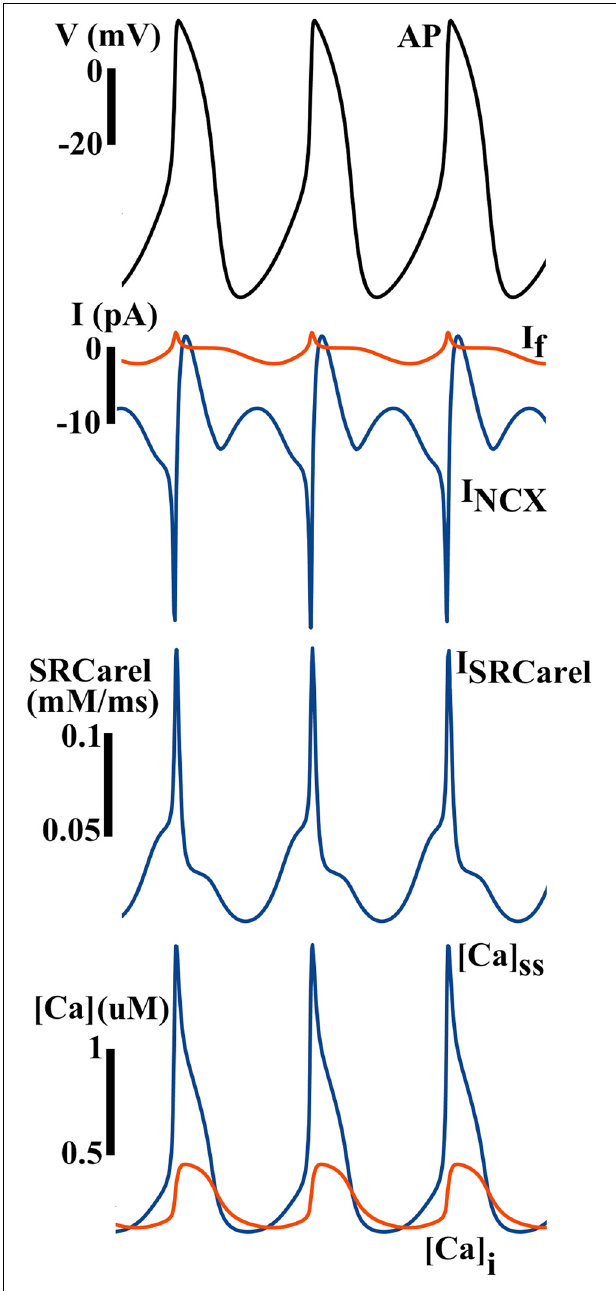
FIGURE 7 | Simulated AP and ionic currents using the ML SAN model to illustrate the Ca clock hypothesis. Blue arrows indicate that the changes in I NCX during the diastolic depolarization finally trigger a spontaneous AP, while the contribution of I f is much less. Inward I NCX during the DD is secondary to spontaneous Ca release from the SR ( I SRCarel ), which gives rise to subspace and myoplasmic Ca concentrations ( [ Ca ] ss and [ Ca ] i ) elevation during the